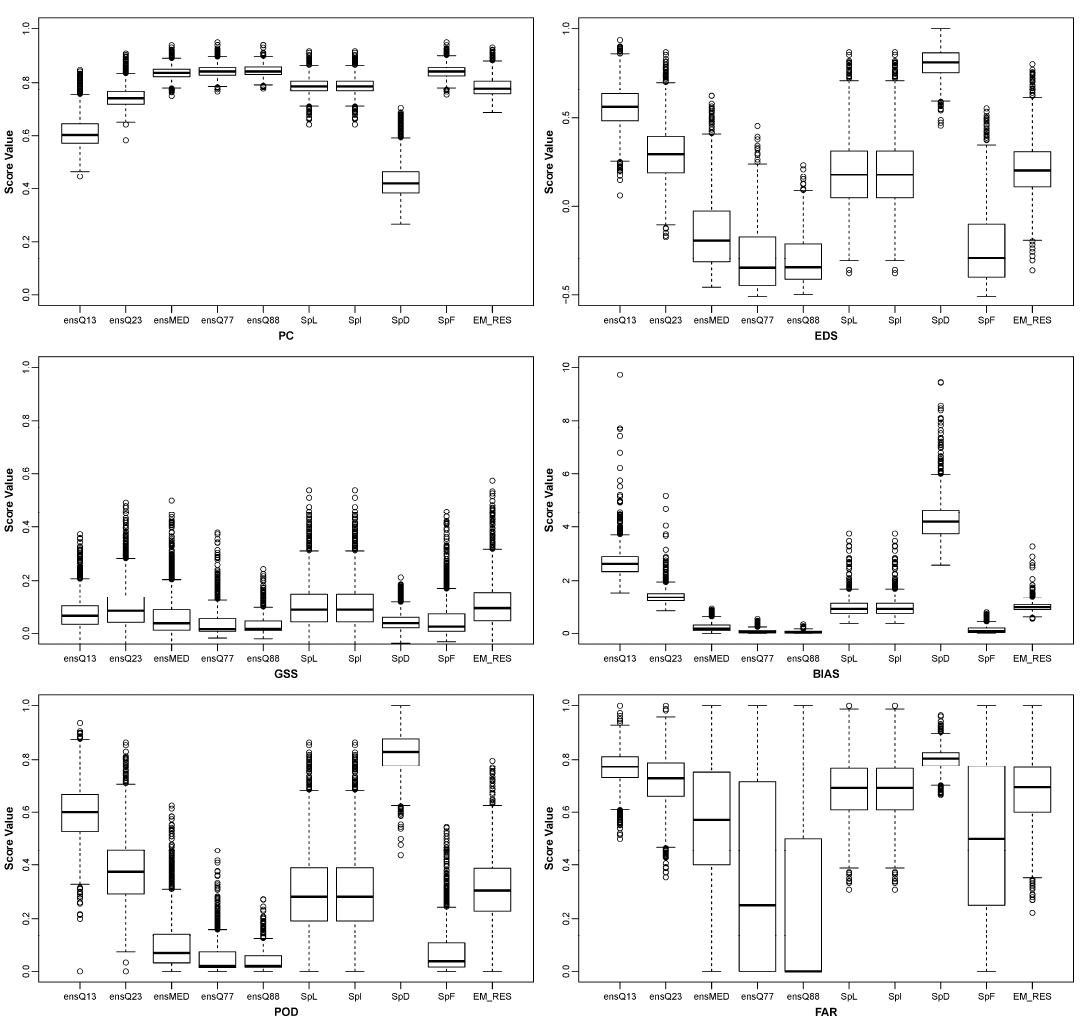
Figure A5. Verification measures of categorical drought forecasts (i.e., below the SPI6 “-1” threshold) estimated with the methods described in Table A2.